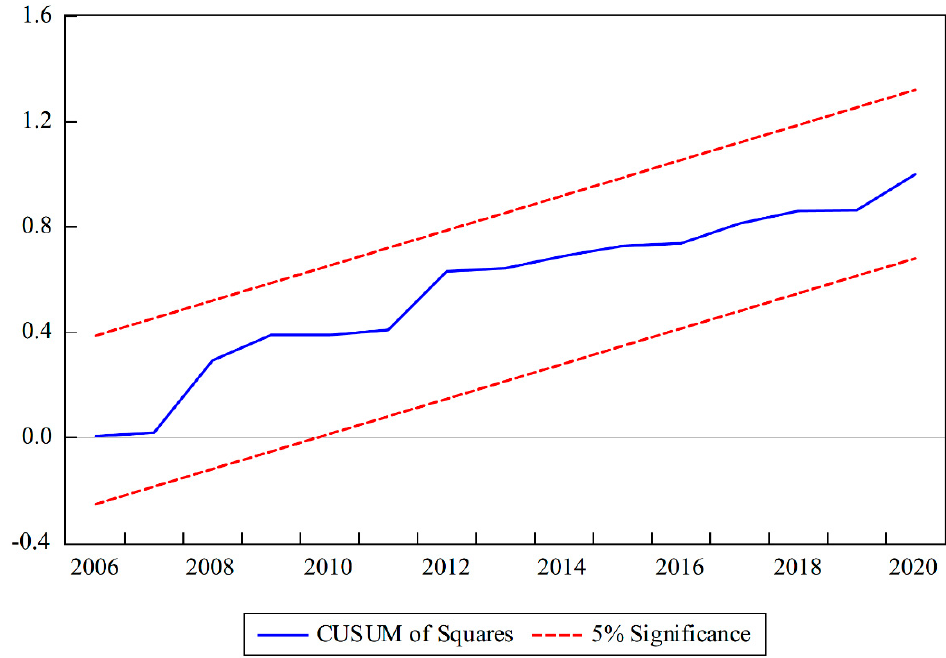
Figure 5. The plot of the cumulative sum of squares of recursive residuals (CUSUMSQ). The dashed lines are critical boundaries at 5% significance level.